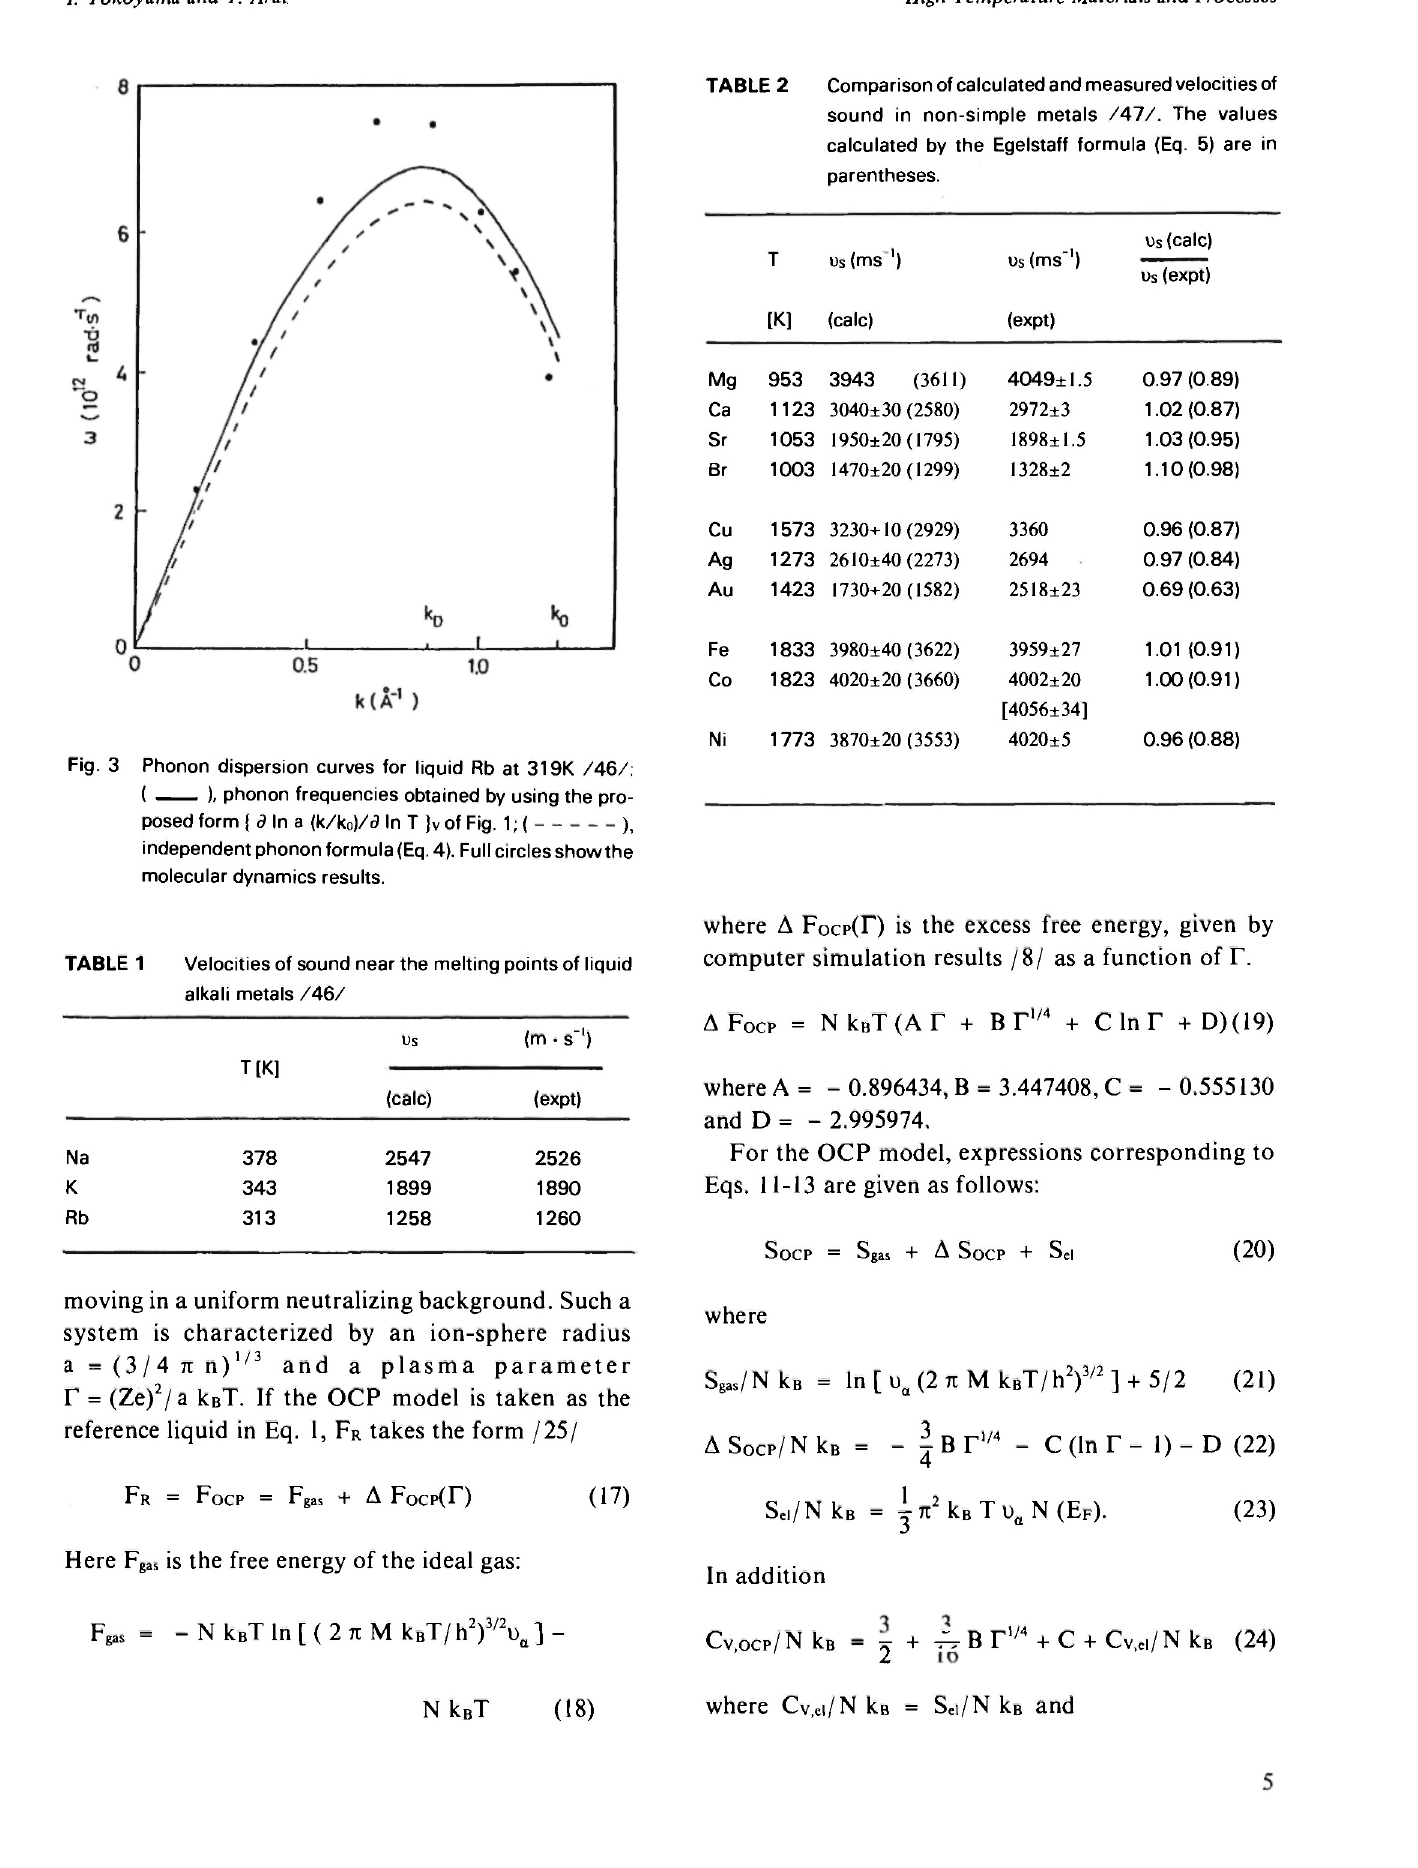
Fig. 3 Phonon dispersion curves for liquid Rb at 319K /46/: ( ), phonon frequencies obtained by using the pro- posed form j d In a (k/k 0 )/d In Τ } v of Fig. 1; ( ), independent phonon formula (Eq. 4). Full circles show the molecular dynamics results.